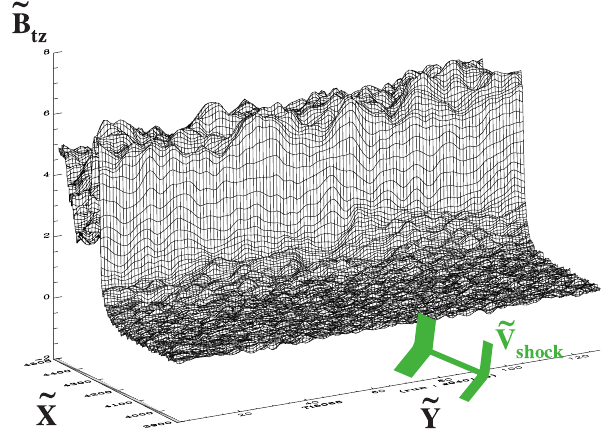
Fig. 2. Enlarged view of the main magnetic field component b B tz (x,y) around the shock front at the time ( b t ≈ 6 . 3 b ω for the test particles